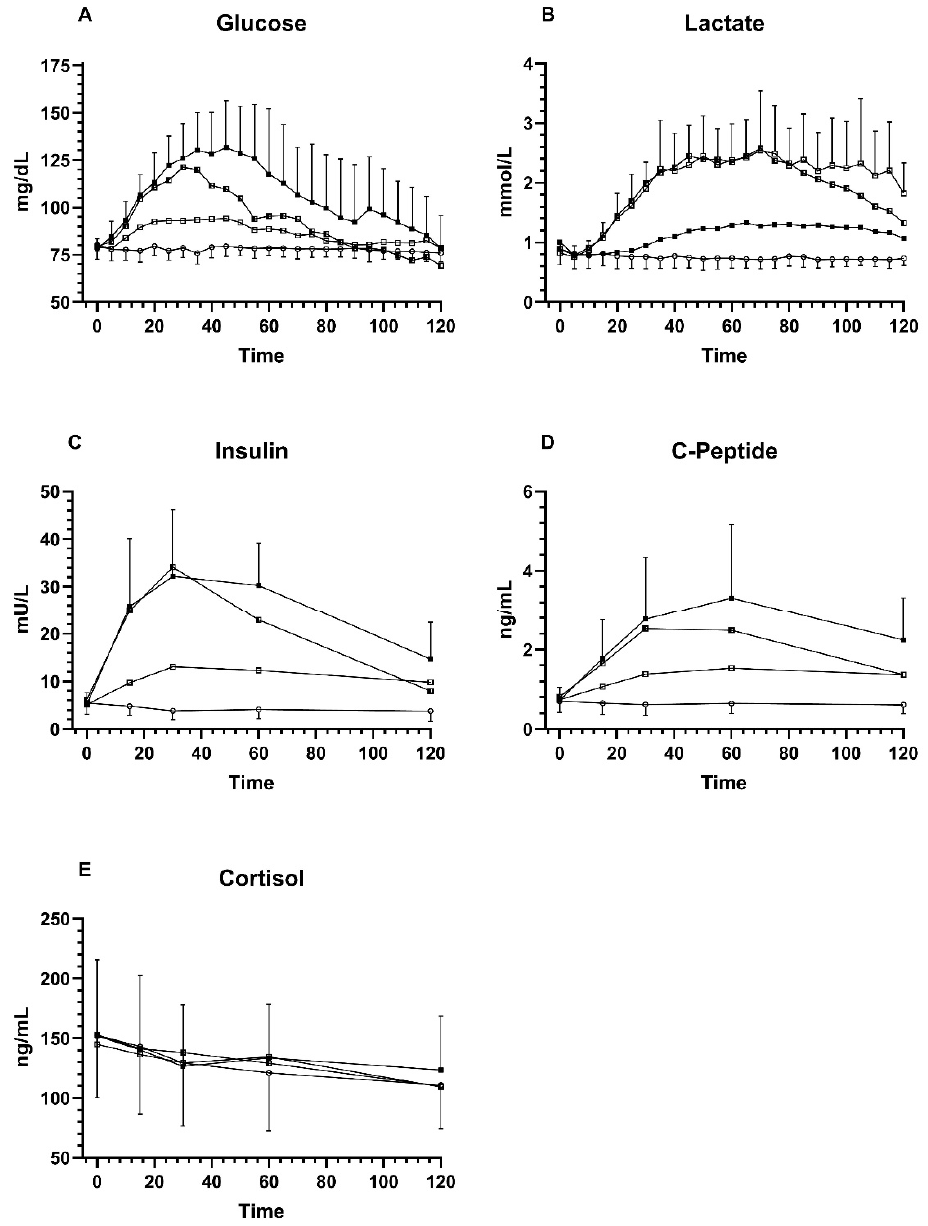
Figure 1. Comparison of Glu, Fru, GluFru, and sucralose supplementation. ( A ) venous blood glucose, ( B ) venous blood lactate, ( C ), serum insulin levels, ( D ) serum c-peptide levels, and ( E ) serum cortisol levels. Black circles indicate glucose, open circles indicate sucralose, open squares indicate fructose, and half squares indicate GluFru.